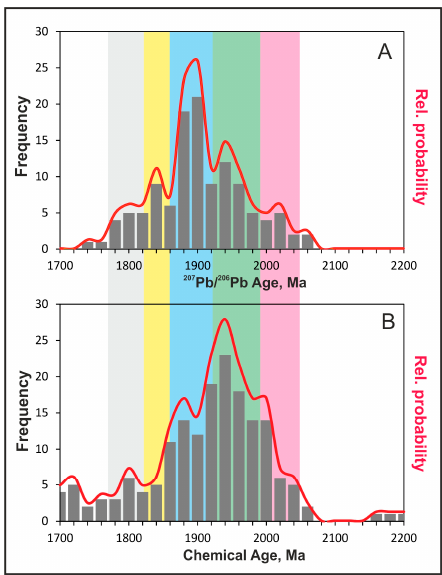
Figure 7. Frequency distribution/relative probability diagrams for 207 Pb/ 206 Pb ages ( A ) and chemical ages ( B ) of uraninite for the samples in this study. Chemical ages shown on this figure are from the same set of samples which were used for in situ U–Pb age dating of uraninite by LA-ICP-MS, and can